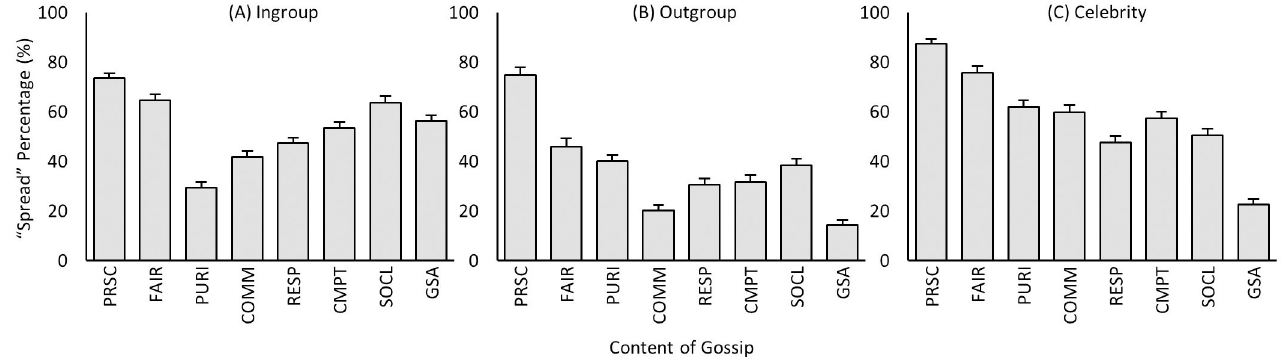
Fig 7. Mean gossip spread rates of 2-way interaction ‘content x target’. (A)-(C) Mean spread rates of eight different content domains for ingroup, Outgroup, and celebrity target, respectively. (PRSC: prosociality, FAIR: fairness, PURI: purity, COMM: community, RESP: respect, CMPT: competition, SOCL: social- oriented, GSA: general social affairs.) See S2 Table in S1 Text for statistical significance.